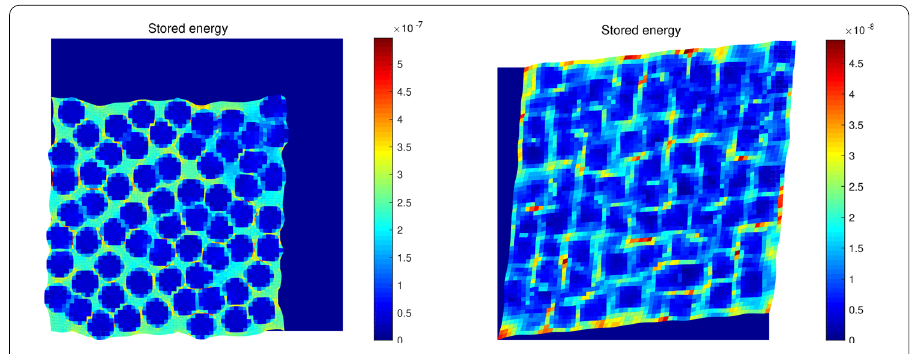
Fig. 3 Deformed mesh and stored energy density [MJ/m 2 ] of the meso-scale response under bi-axial uniform compression and pure shear with periodic boundary